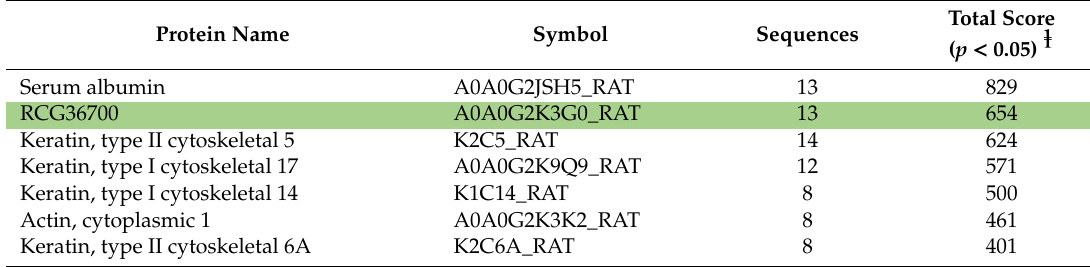
Figure 7. KEGG pathways for deiminated proteins in plasma-EVs of sham and pre-motor PD model rats. ( A ) KEGG pathways identified in circulating plasma-EVs of sham (control) rats are highlighted. See colour code for nodes included in the figure. ( B ) KEGG pathways identified for deiminated proteins in circulating plasma-EVs of the pre-motor PD model rats are highlighted. See colour codes for nodes and connecting lines in the figure. Table 3. Deiminated proteins in plasma-EVs of sham-treated rats ( Rattus norvegucus ), as identified by Figure 95. and LC-MS / MS analysis. Deiminated proteins in sham-treated rat plasma were isolated by immunoprecipitation using the pan-deimination F95 antibody. The resulting F95-enriched eluate was then analysed by LC-MS / MS and peak list files submitted to mascot. Rattus norvegicus species-specific peptide sequence hits are listed, showing number of sequences for protein hits and total score. Green highlighted rows indicate protein hits identified in sham-treated (control) rat plasma